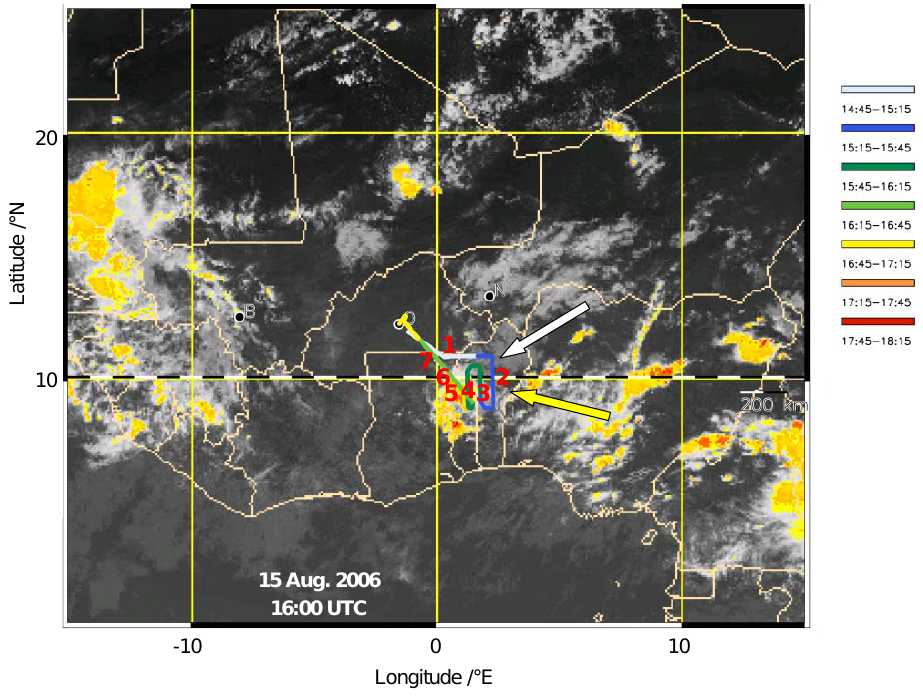
Fig. 6. Meteosat Second Generation (MSG) brightness temperatures over West Africa on 15 August 2006 at 16:00 UTC (red 195 K, orange 210 K, yellow 225 K). Superimposed are the Falcon flight track from Ouagadougou in Burkina Faso (colour-coded according to UTC time) and the sequences with elevated NO mixing ratios ( ≥ 0 . 3 nmol mol − 1 ) labelled 1–7. Capital cities of Mali and Niger are indicated with black dots (B = Bamako to the west, N = Niamey to the east). The white arrow indicates the direction of the storm motion and the yellow arrow the main wind direction in the anvil outflow (not scaled according to velocity).